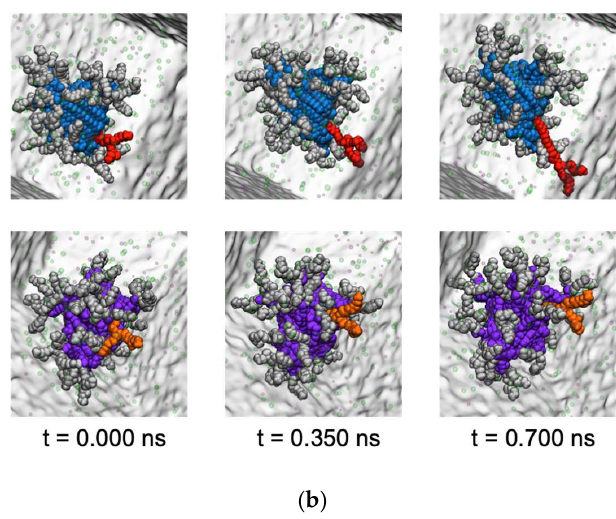
Figure 15. ( a ) Distance between the center of mass (COM) of the C 22 G 1 and the CholSG 1 self-assembled dendrimers and the COM of the selected dendron subjected to the different pullover forces (labelled on the left) during the corresponding CF-SMD simulations. ( b ) CF-SMD simulation snapshots of a micelle of the C 22 G 1 (upper panel) and the CholSG 1 self-assembled dendrimers TEM experiencing a pullout force of 1.6 kcal/mol Å taken at the same three representative times along the respective simulation trajectories. In both panels, the dendrons in each micelle are shown by their van der Waals surface, colored as follows: Hydrophobic cores, blue ( C 22 G 1 ) and purple ( CholSG 1 ); common hydrophilic head, gray; pullout monomers, red ( C 22 G 1 ) and orange ( CholSG 1 ). Na + and Cl − ions are shown as pink and green transparent spheres, while water is represented by a transparent light gray field. Adapted from [29] with the permission of The Royal Society of Chemistry.